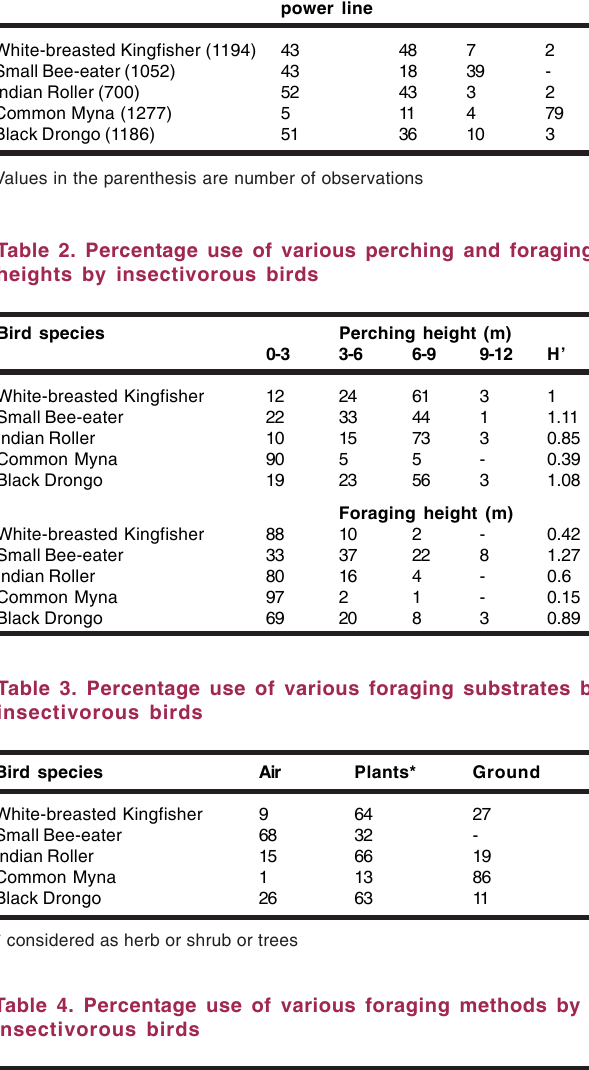
Table 1. Percentage of various perch types used by insectivorous birds in the study area Bird species